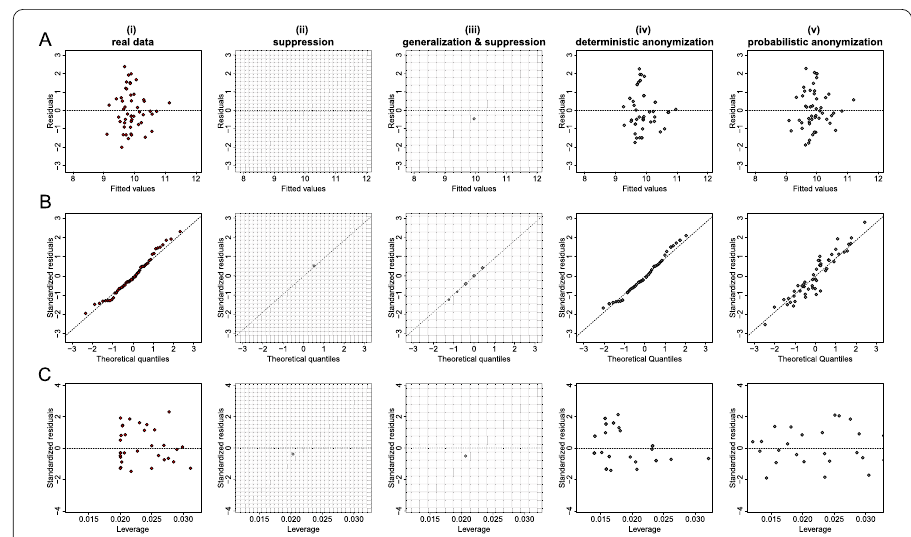
Figure 17 The performance of the techniques applied in a sample of 50 observations. From top to bottom we demonstrate the residuals vs fitted values plots ( A ), normal QQ plots ( B ), and standardized residuals vs leverage plots ( C ) for real regression outcomes (i), suppressed regression outcomes (ii), generalized and suppressed regression outcomes (iii), deterministically anonymized regression outcomes (iv) and probabilistic anonymized regression outcomes